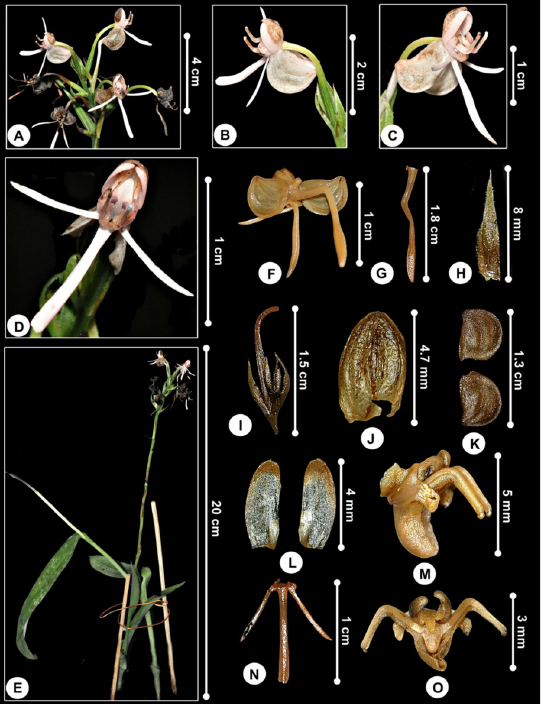
Fig 8. Habenaria rostellifera . A. Inflorescence. B, C, D. Flower from lateral and front view. E. Plant. F. Flowers from back view showing spur. G. Spur. H. Floral bract. I. Pedicel-with-ovary and floral bracts. J. Dorsal sepal. K. Lateral sepals. L. Petals. M. Gymnostemium from lateral view showing anther canals. N. Trilobed labellum. O. Gymnostemium from top view showing protruding rostellum. Note: F-O are preserved